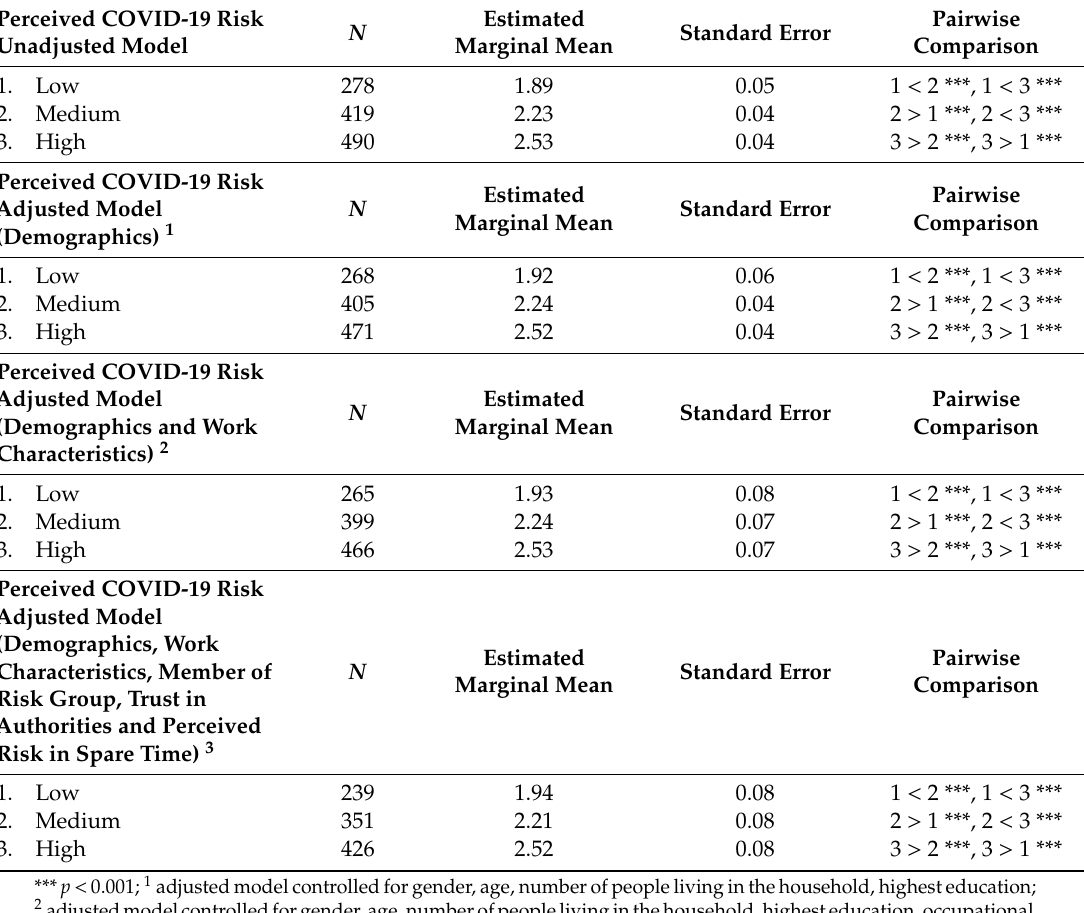
Unadjusted and adjusted e ff ects of perceived COVID-19 risk on stress